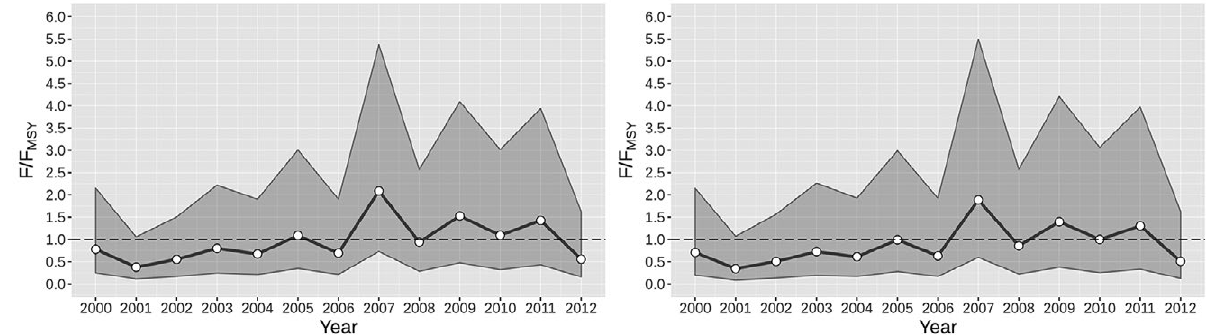
Fig. 8. – Time series of ratios between estimated exploitation rates and exploitation rate at maximum sustainable yield (F Bayesian state-space surplus production models. Left, Pella-Tomlinson model; Right, Schaeffer model.